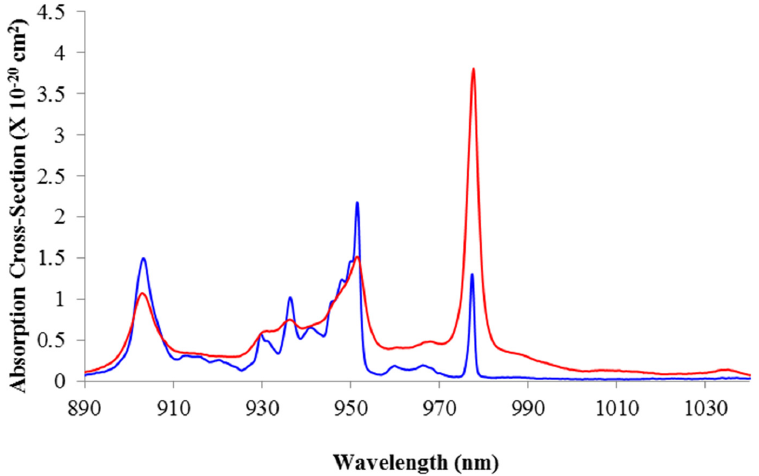
Figure 35. Absorption cross-section as a function of wavelength for a hydrothermally-grown Yb 3+ :Lu 2 O 3 laser crystal at 80 K (blue) and 298 K